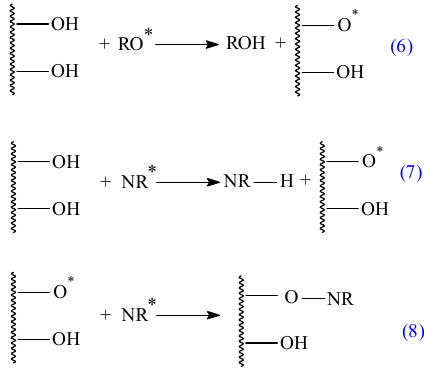
Figure 9. The chemical modification of flax or sawdust fibers by peroxide reaction.